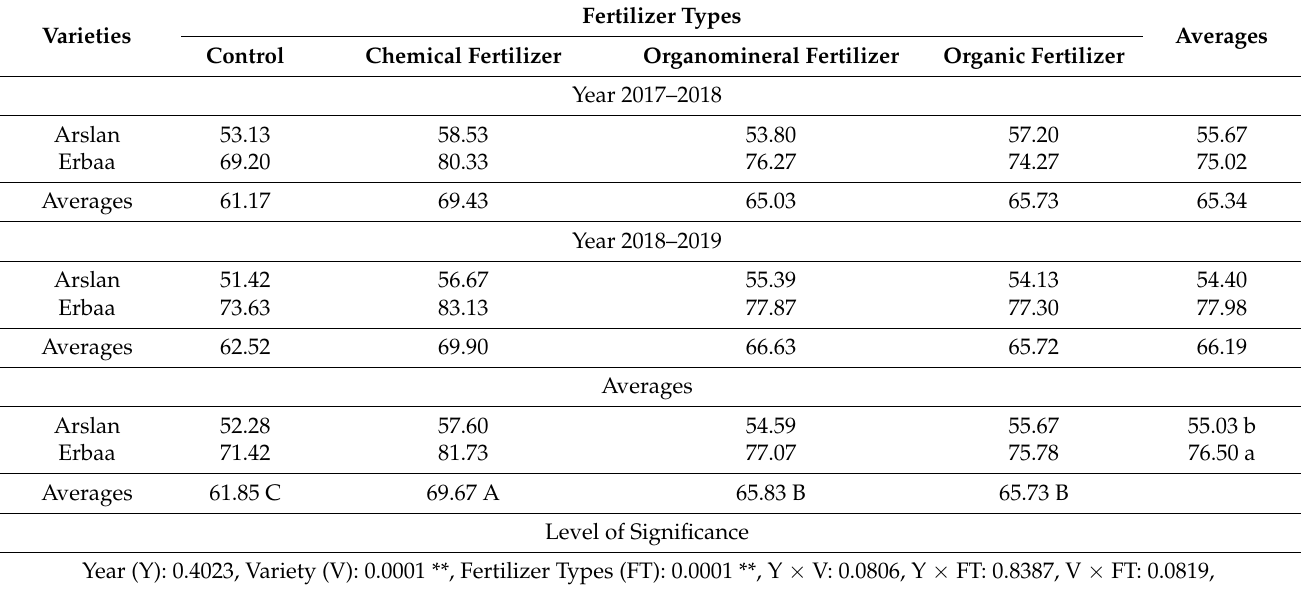
Table 3. Effect of fertilizer types on plant height of coriander varieties (cm) 1 .